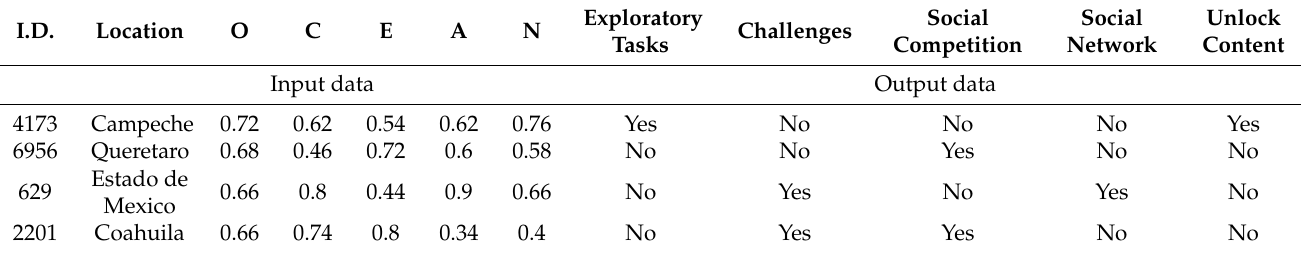
Table 2. Variables considered to build the personality traits’ ANN.